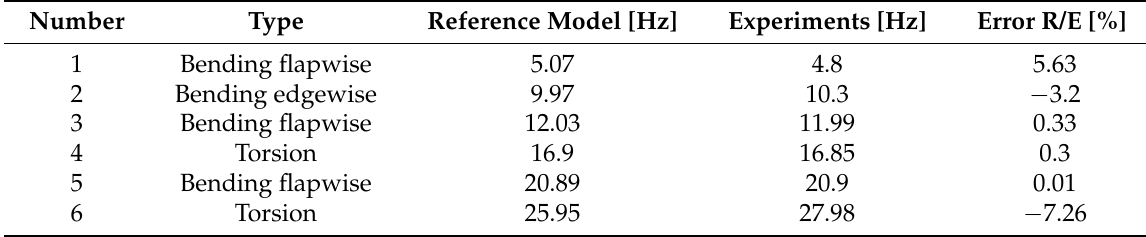
Table 10. Eigenfrequencies in free–free configuration of the rotor blade simulated in